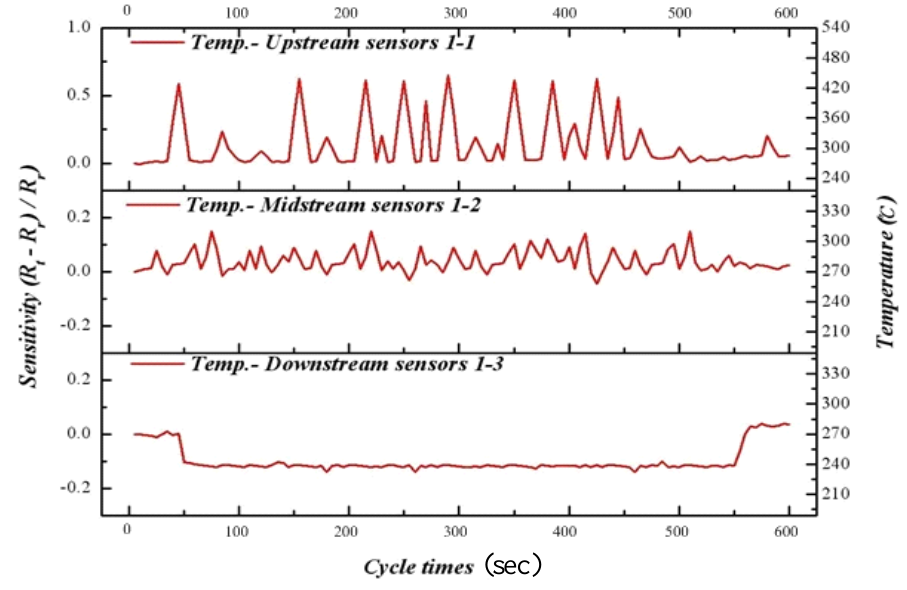
Figure 8. Inner temperature distribution of micro reformer at area 1-1, 1-2, 1-3 (OSRM; 270  C).